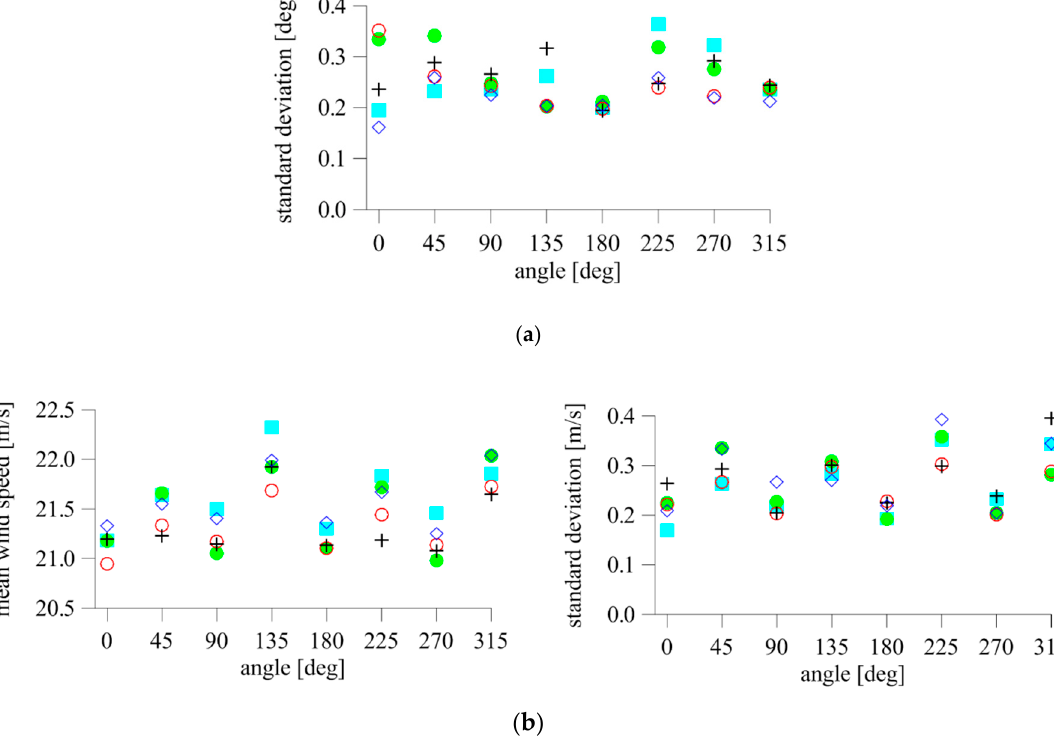
Figure 8. Mean and standard deviations of ( a ) wind angle and ( b ) wind speed;  —A1,  —A2,  — A3,  —A4,  —A5. • —A4, #